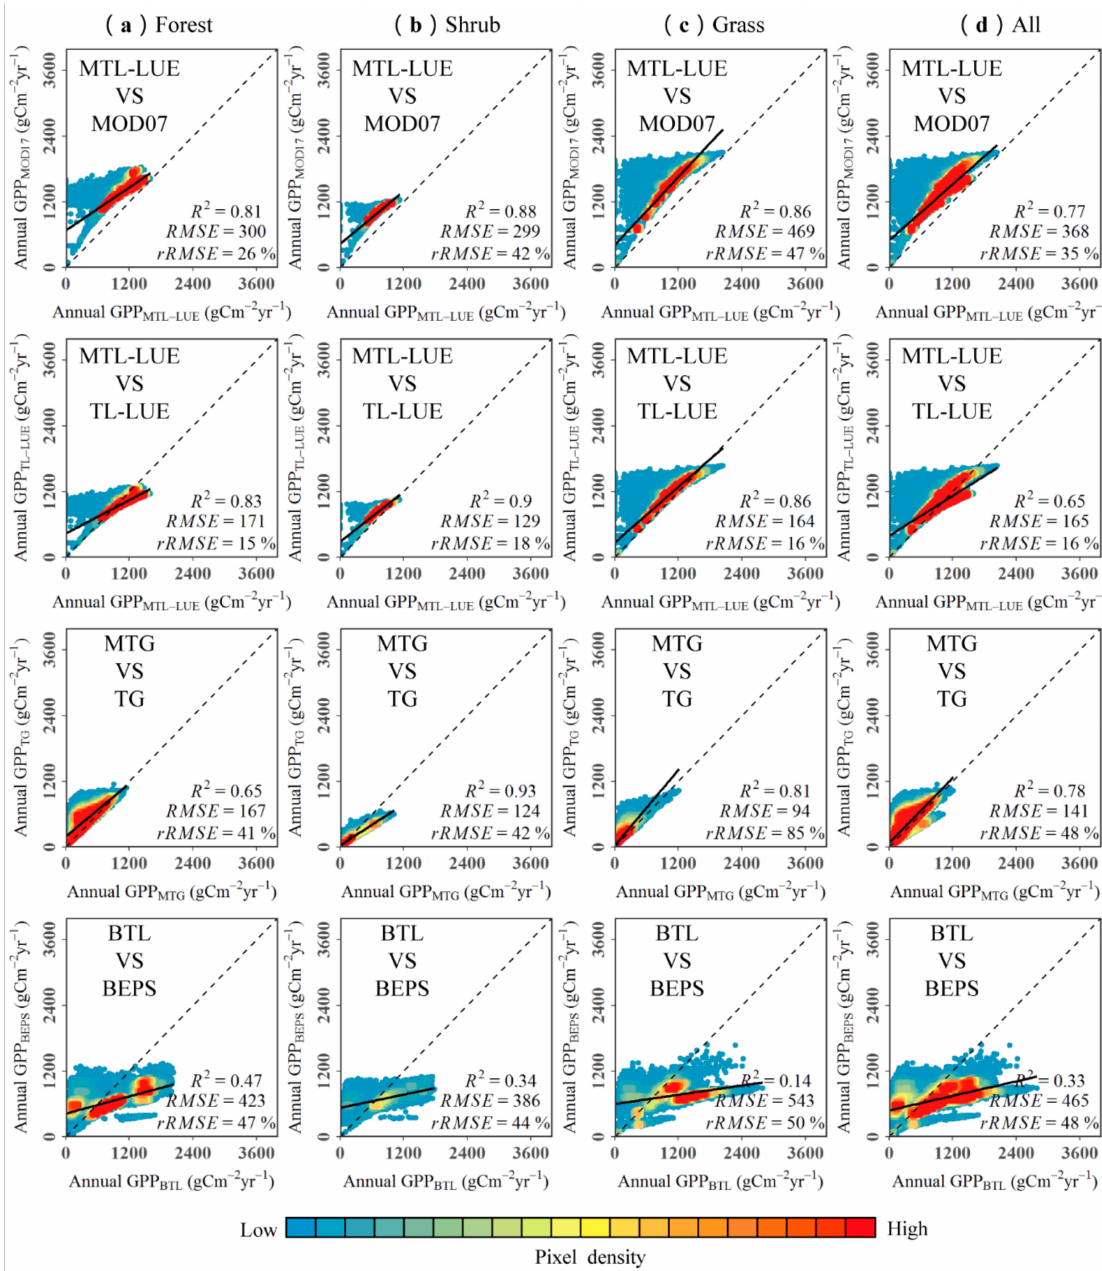
Figure 4. Comparisons between annual GPP MTL-LUE and GPP MOD17 (the first row), GPP MTL-LUE and GPP TL-LUE (the second row), GPP MTG and GPP TG (the third row), and GPP BTL and GPP BEPS (the forth row) in forest ( a ), shrub ( b ), grass ( c ), and all ( d )